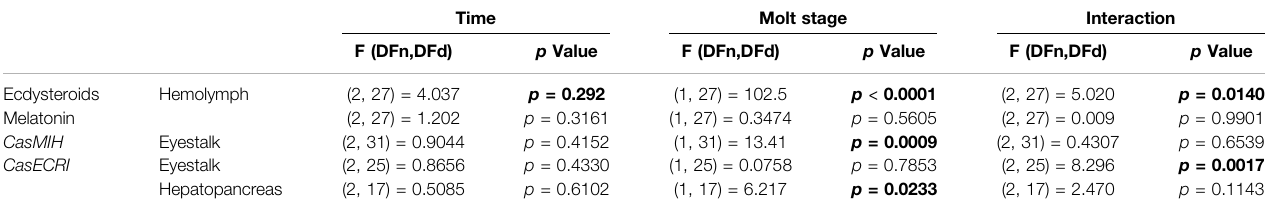
TABLE 2 | ANOVA parameters related to gene expression and hormone concentrations.